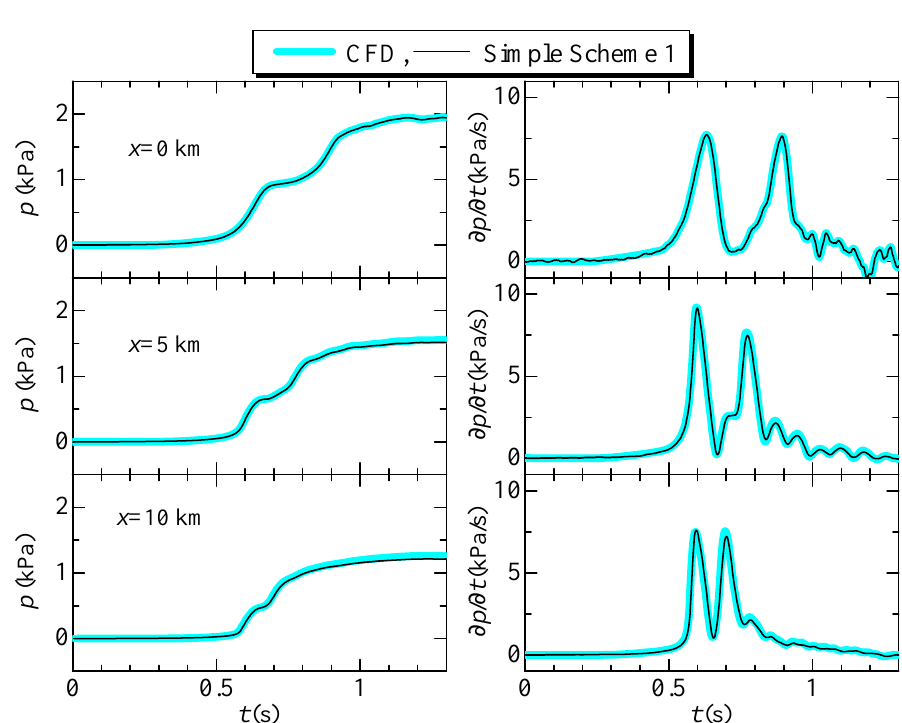
Fig. 6 Comparison of compression waveforms (CASE